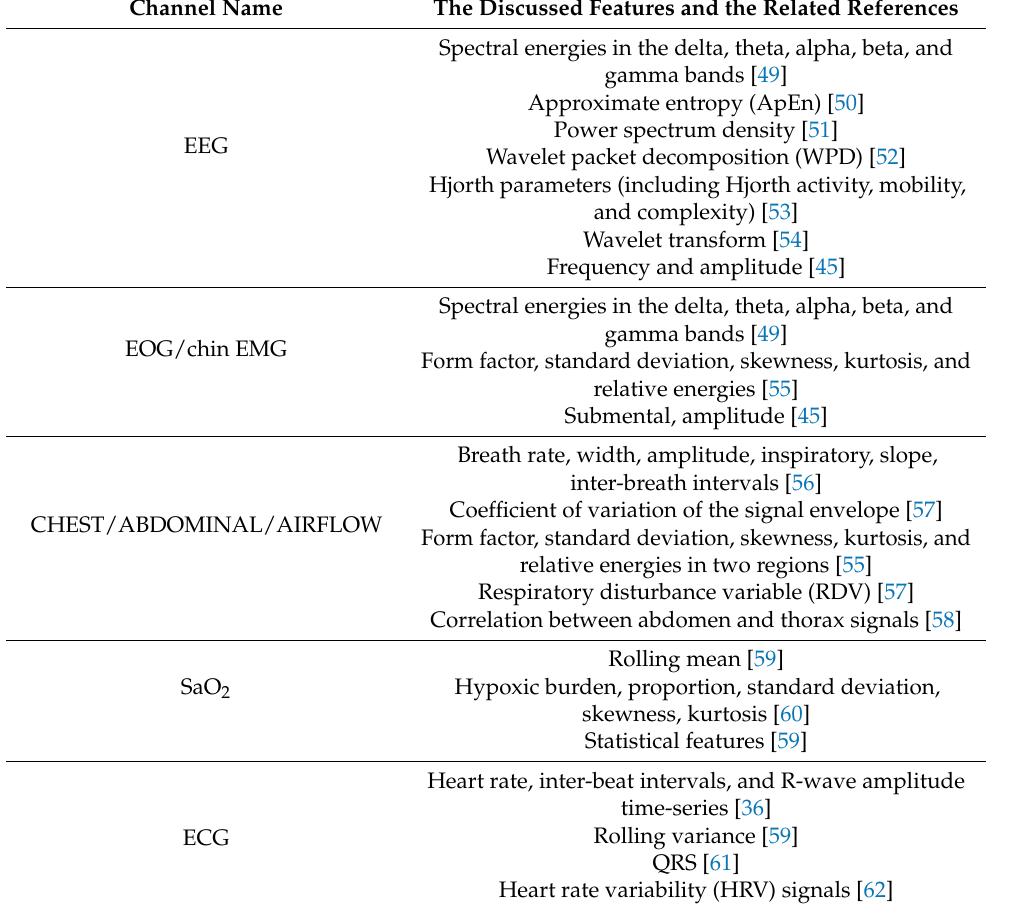
Table 2. Common characteristics of PSG in arousal detection with machine learning